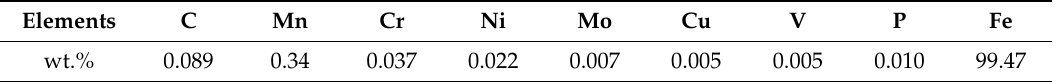
Table 1. The chemical composition of mild steel